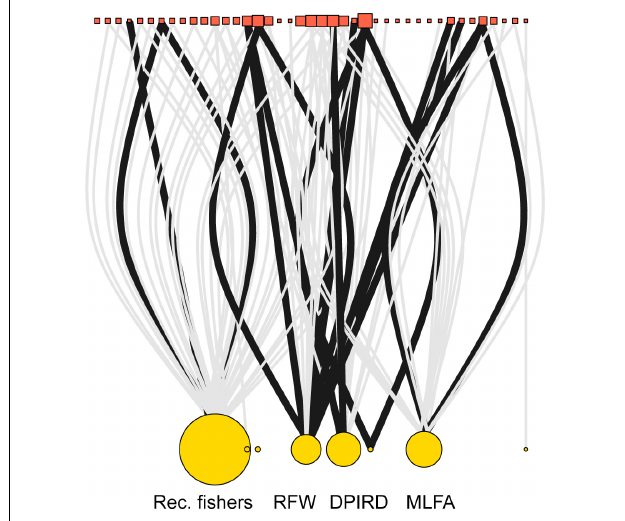
FIGURE 4 | Bipartite network of recreational fishers network and the organizations (i.e., nodes) with which they exchange information. Recreational fishers are denoted by red squares, while organizations are represented by yellow circles. Organizations with degree centralities exceeding 0.1 are labeled, and node size reflects the degree centrality. Edges that are wider and black highlight information exchanges that are perceived by recreational fishers to be of low quality. Refer to Table 1 for information on which acronym corresponds to each organisation.